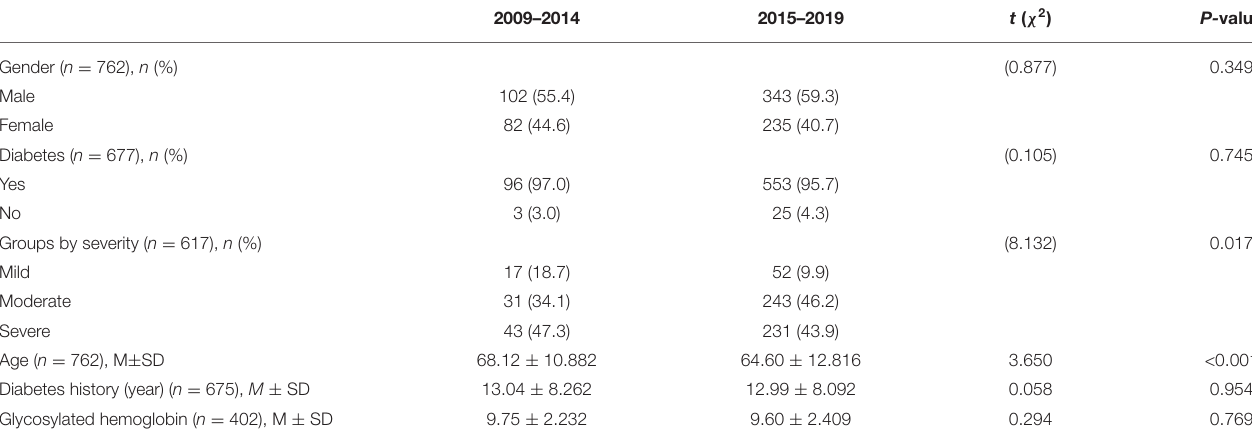
TABLE 3 | Sociodemographic characteristics of diabetic patients.